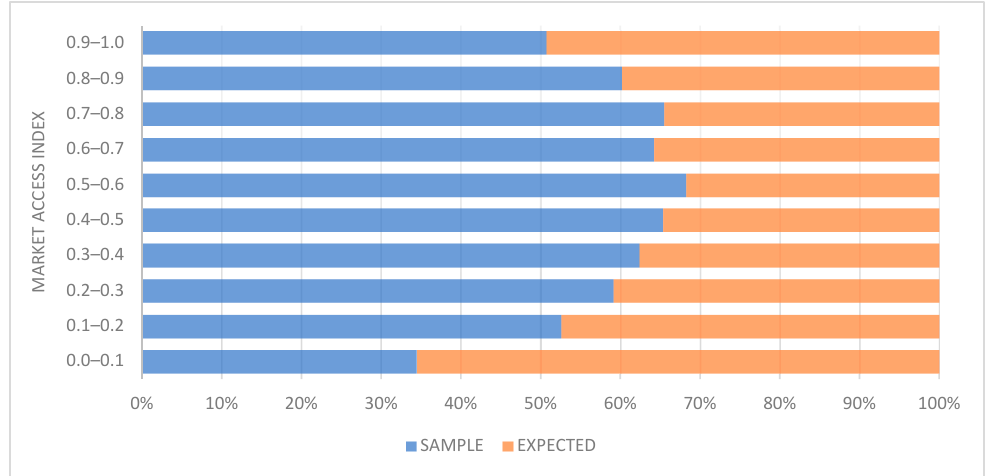
Figure 10. Percentage of Observed (~Sample) vs. Expected Counts for Market Accessibility Variable.